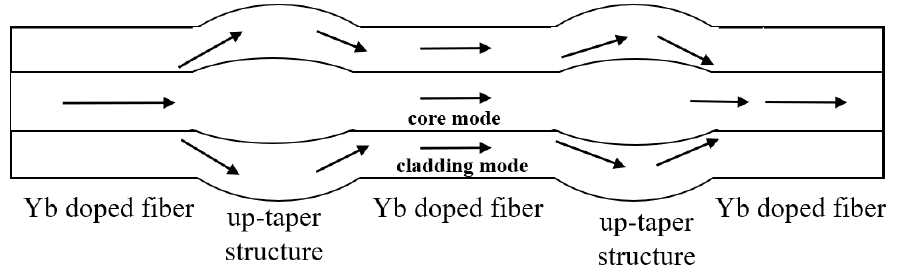
Figure 1. Schematic diagram of up-taper structure on Yb doped fiber.